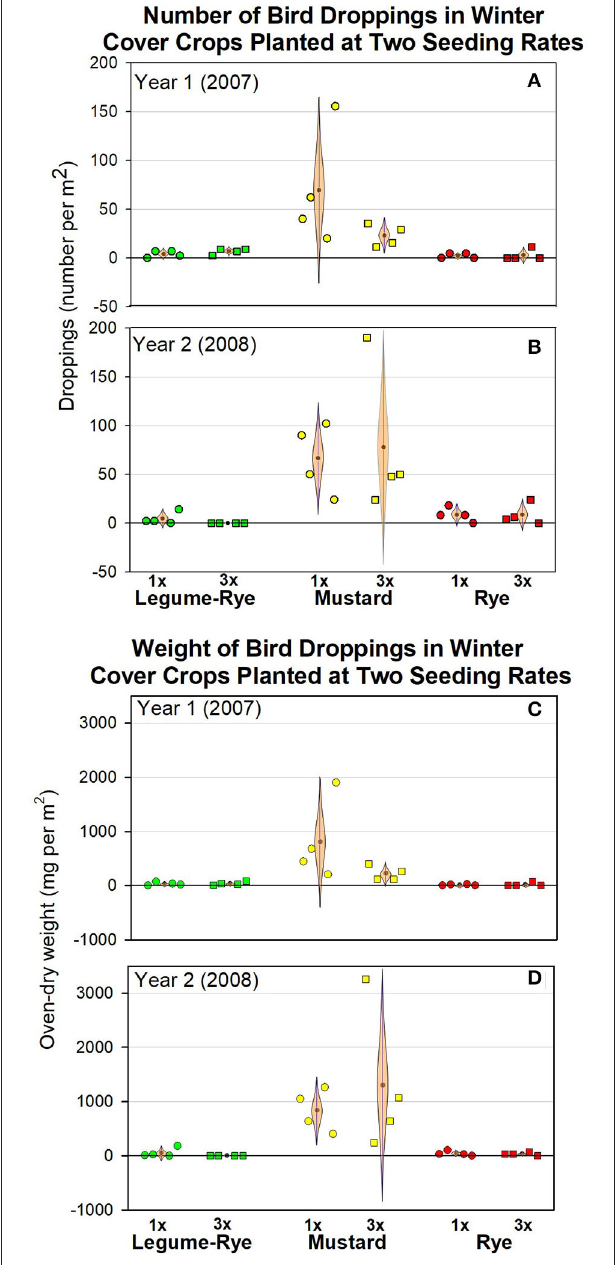
FIGURE 3 | The number (A,B) and weight (C,D) of bird droppings under three winter cover crops planted at two seeding rates during two winters in Salinas, California. The data were collected in Feb 24 (Year 1) and Feb 13 to 15 (Year 2) that was ∼ 16–17 weeks after planting. The standard (1x) and high (3x) seeding rates in kg per ha were 140 and 420 (legume-rye), 11 and 33 (mustard), and 90 and 270 (rye). The light brown, cat’s eye shaped error bars are 95% confidence intervals (CIs) with the sample mean at the central point on the bar. The CIs are shown in this shape to help illustrate how plausibility varies along the CI with values at the fattest (i.e., widest horizontal) area near the mean being several times more plausible to be the population mean ( µ ) than values at the ends of the CI. Data points are clustered around the mean in order of replicates 1–4. The data in this figure are available in the Supplementary Materials